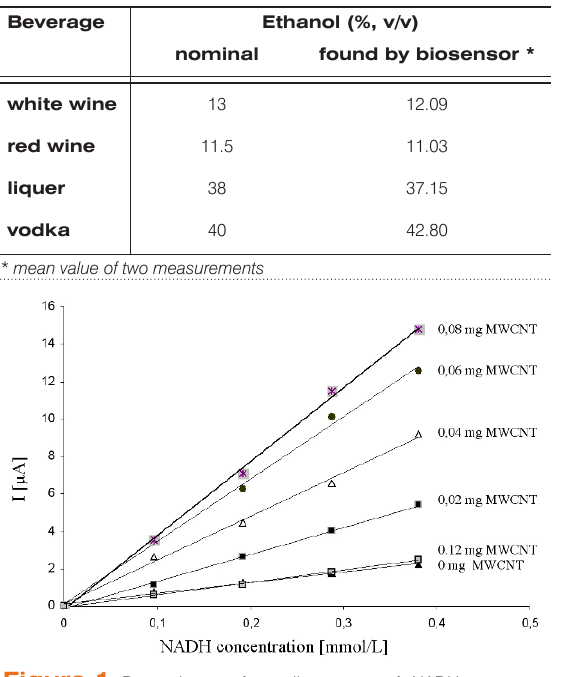
Figure 1. Dependence of anodic current of NADH sensor on the amount of MWCNT incorporated onto matrix layer; E = -50 mV vs. Ag/AgCl; supporting electrolyte: app. 0.1 mol/L phosphate buffer solution, pH